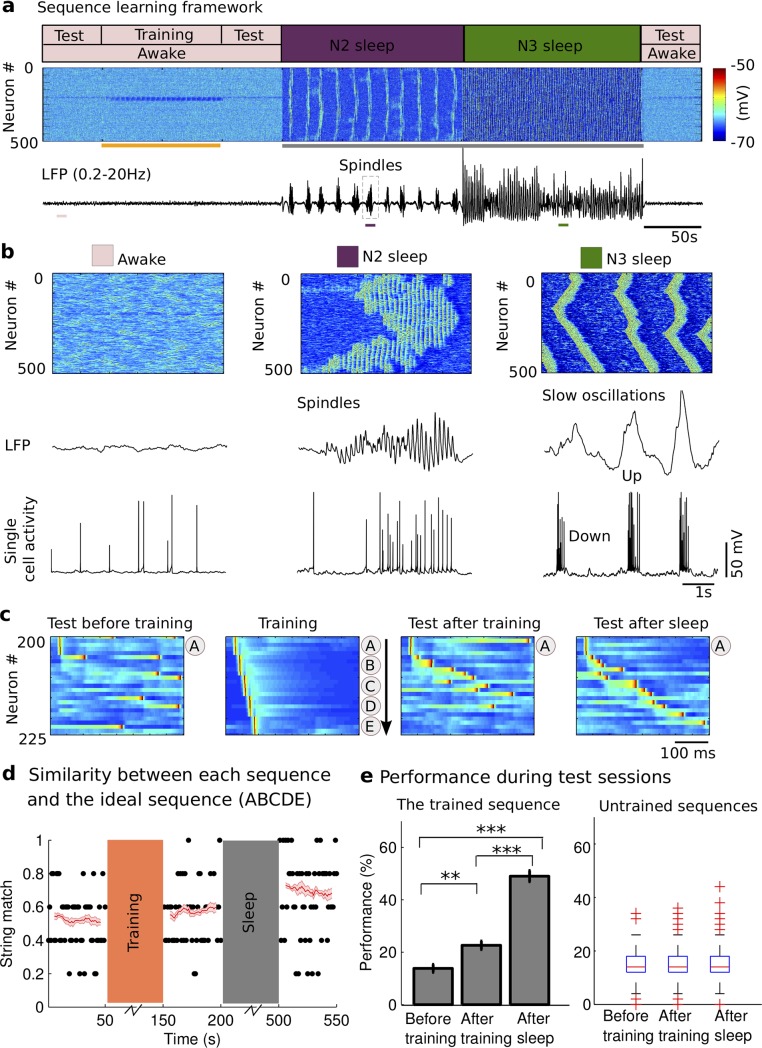
Network dynamics and sequence learning paradigm.a) The cortical network activity during transitions from awake state (pink block, top), to N2 sleep (purple block), to N3 sleep (dark green block) and back to the awake. Raster plot (middle) shows membrane voltages of cortical pyramidal cells. Broadband filtered local field potential (LFP, bottom) from the cortical population. The sequence was learned during the training period (orange bar). Grey bar represents the period of sleep. The performance was tested in three test sessions: before training, after training before sleep, and after sleep. b). The expanded view of characteristic spatiotemporal patterns (top), LFP (middle) and single cell activity of neuron #200 (bottom) during awake (left), N2 sleep (middle) and N3 sleep (right) from where pink, purple, dark green bars are shown in a (bottom). The spindle activity during N2 sleep revealed a typical waxing-waning pattern, consisted of 7–14 Hz brief bursts of rhythmic waves. The slow oscillations (<1Hz) during N3 sleep consisted of a typical Up and Down state transitions. c) The characteristic examples of a training session and three test sessions. The training included stimulating sequentially at groups A, B, C, D, and E. The test included stimulating only at group A (“pattern completion”). The sequence started at neuron #200. Each group included five neurons and it was stimulated for 10 ms. The delay between groups was 5 ms. d). The dot represents the string match between an ideal sequence (“ABCDE”) and each recalled sequence during test sessions for one trial. The value one represents a perfect match. The red line and the light red patch error bar represent mean and SEM of a moving average string match (window size = 10) over all trials (n = 10). e). The bar plot of the performance that was defined by the probability of recalled sequence with 80% similarity to the ideal sequence “ABCDE” (SM> = 0.8) during each test session. Error bars indicate standard error of the mean (SEM). For the boxplot in the right panel, the central mark indicates the median, and the bottom and top edges of the box indicate the 25th and 75th percentiles, respectively. Left: trained sequence; Right: untrained sequence tested at all other locations. * p<0.05, ** p<0.01, *** p<0.001.